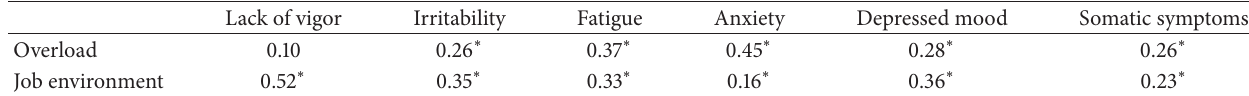
Table 4: Two-factor and stress reactions